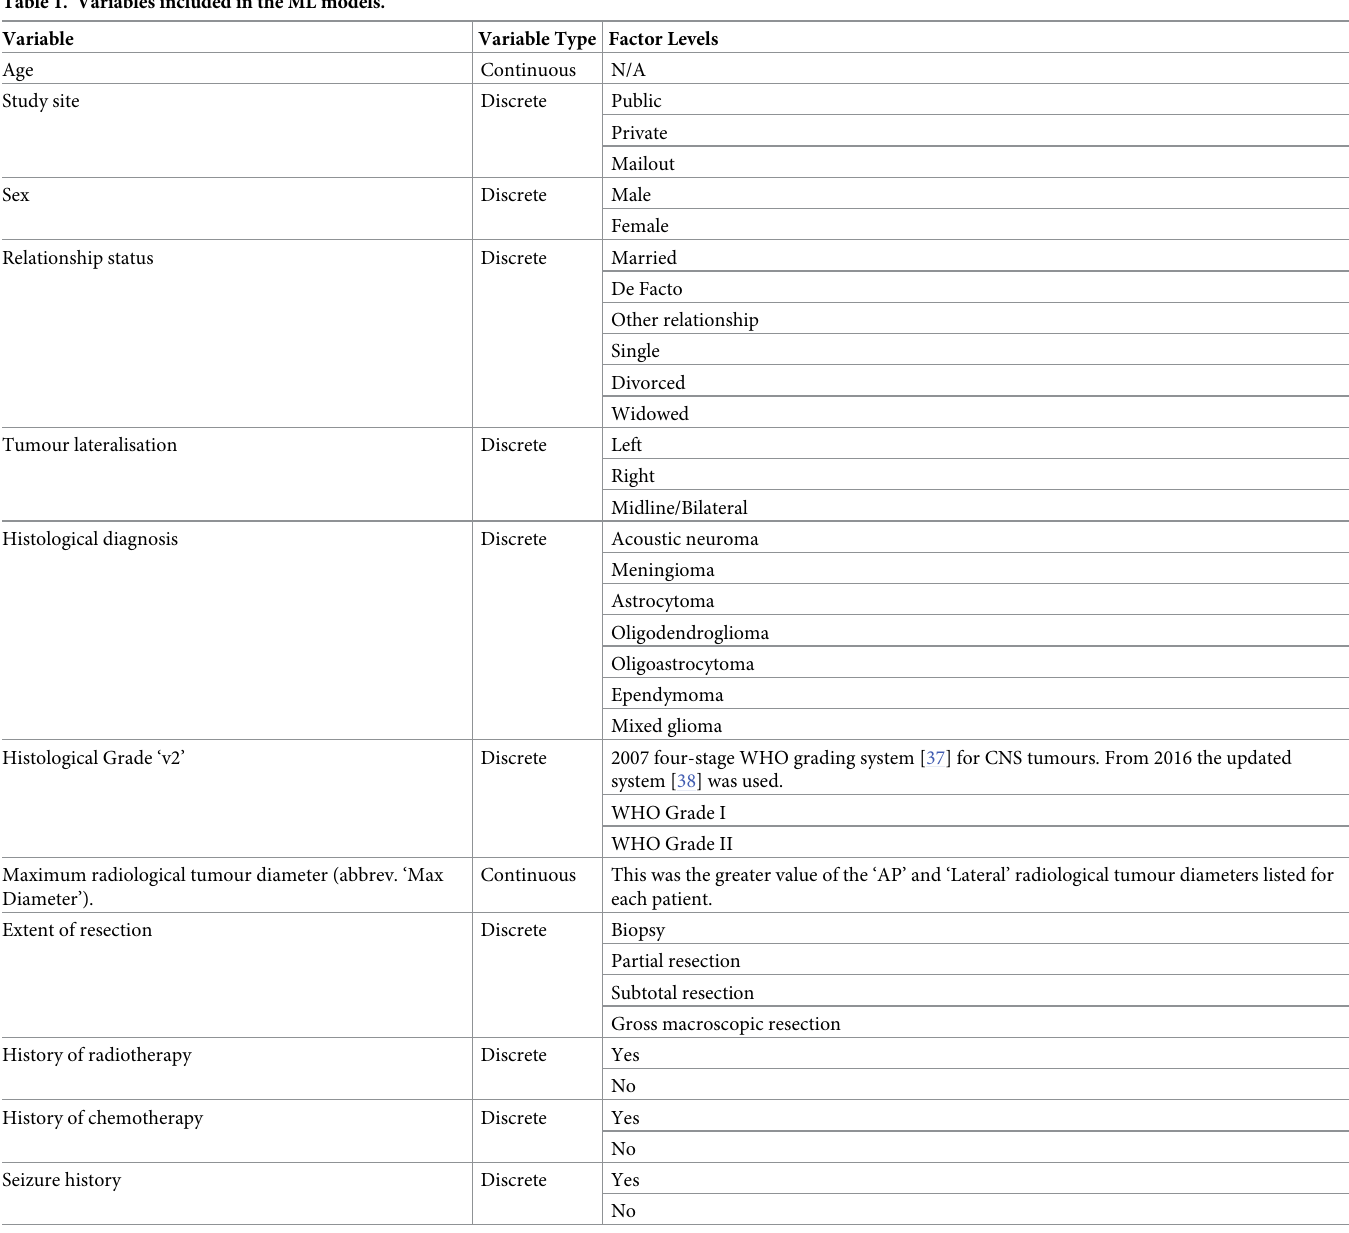
Table 1. Variables included in the ML